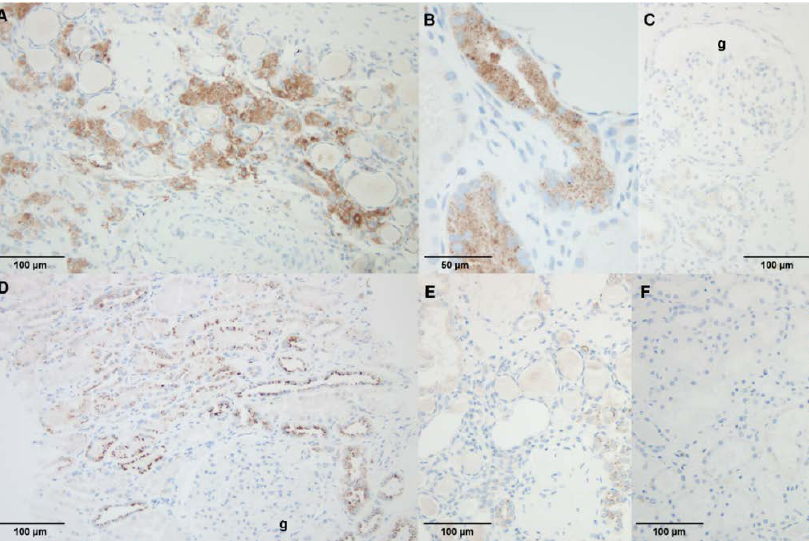
Figure 7. ASAH1-stainings in kidney biopsy specimen. ( A – C ) specimen from a male FD patient (34 years of age) with a classical phenotype with progressive loss of eGFR and macroalbuminuria showing increased ASAH1 expression in the tubular epithelial cells, but not in the glomeruli (g). ( D ) Male non-FD control patient (50 years of age) with chronic renal insufficiency due to hypertensive nephropathy. ( E , F ) Male non-FD control patient (51 years of age) with normal renal tissue adjacent to a primary kidney tumor (with primary antibody, ( E ), and negative control without primary antibody, ( F